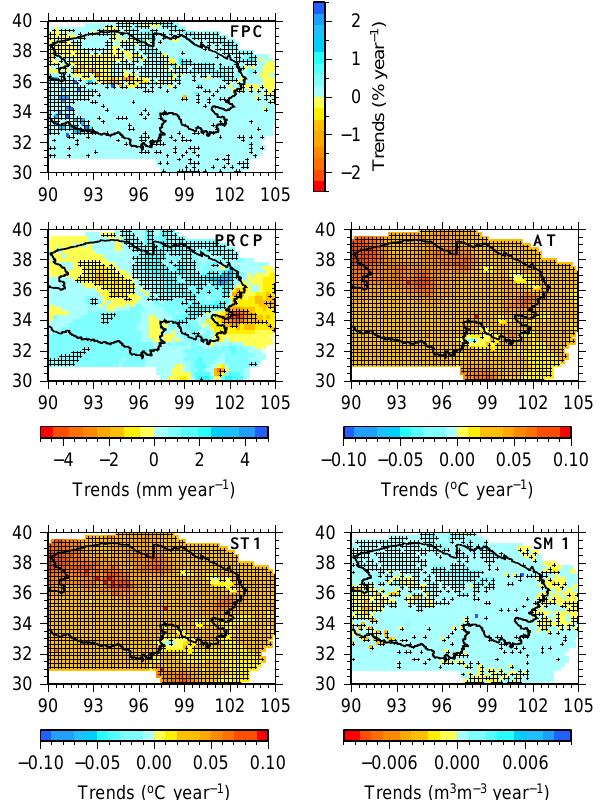
Figure 5. Mann–Kendall trends of simulated annual total FPC, 0–40cm depth soil temperature (ST1), 0–40cm depth soil mois- ture (SM1), and observed precipitation (PRCP) and air temperature (AT). Symbol “ + “ represents statistically significant trends at 95% confidence level.